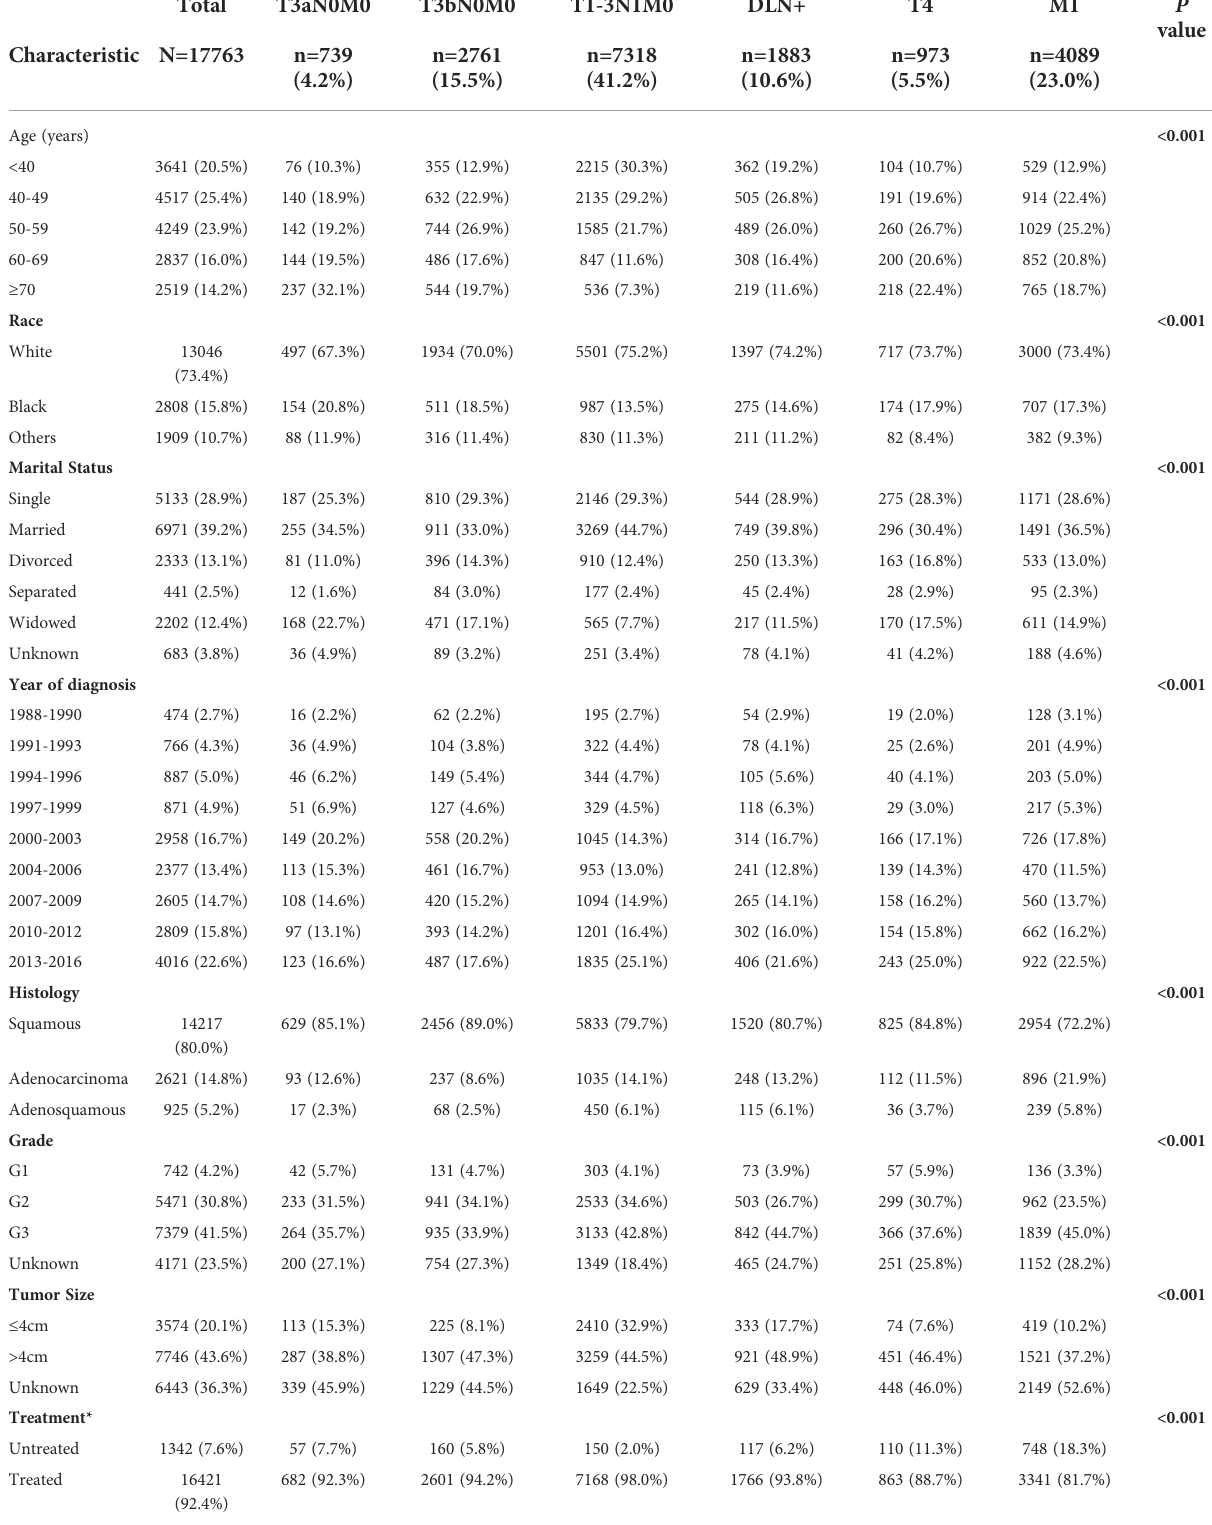
TABLE 1 Demographics and clinical characteristics of patients with stage III-IV cervical